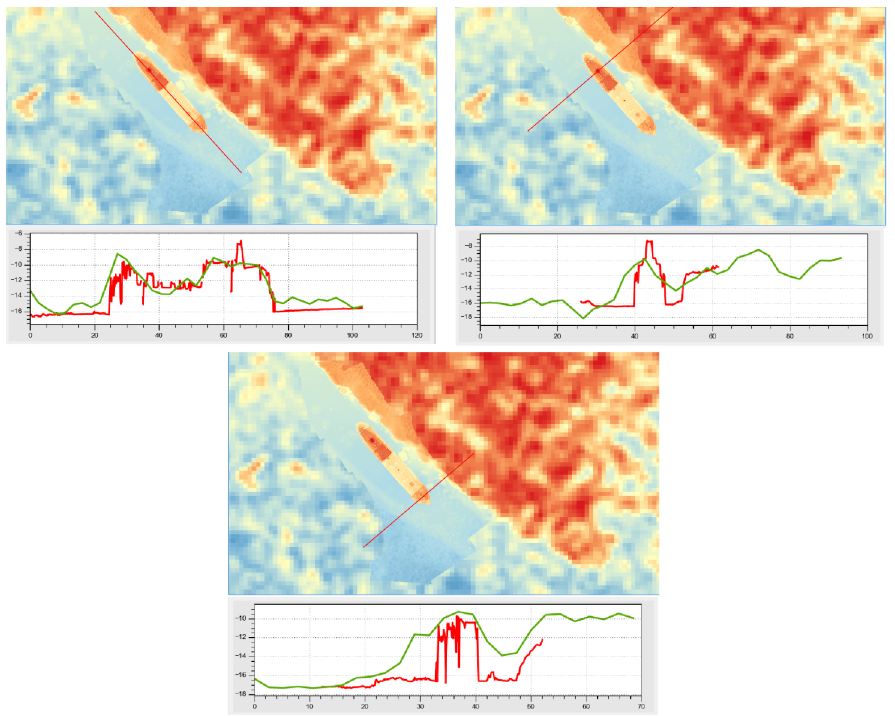
Figure 11: Three examples of bathymetry transects at the Elphis I wreck. Red line represents the sonar bathymetry while green line represents the satellite bathymetry. Maps show sonar bathymetry of Elphis I wreck overlaid on satellite bathymetry of the surrounding